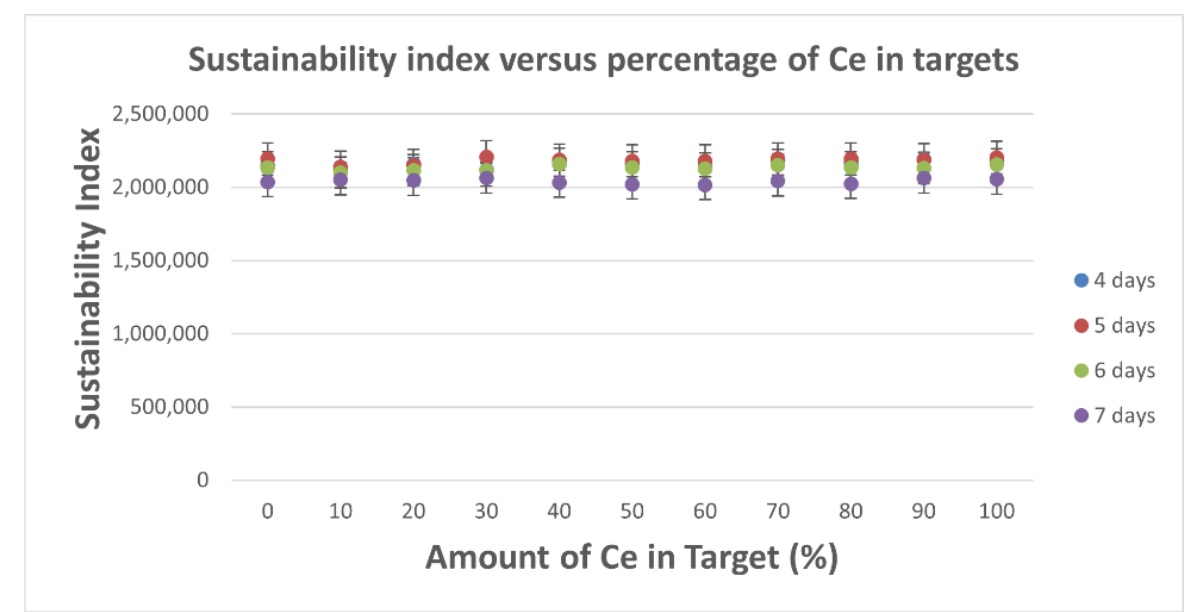
Figure 2. 1% enriched target with height 10 cm and target volume compared to radius plotted.